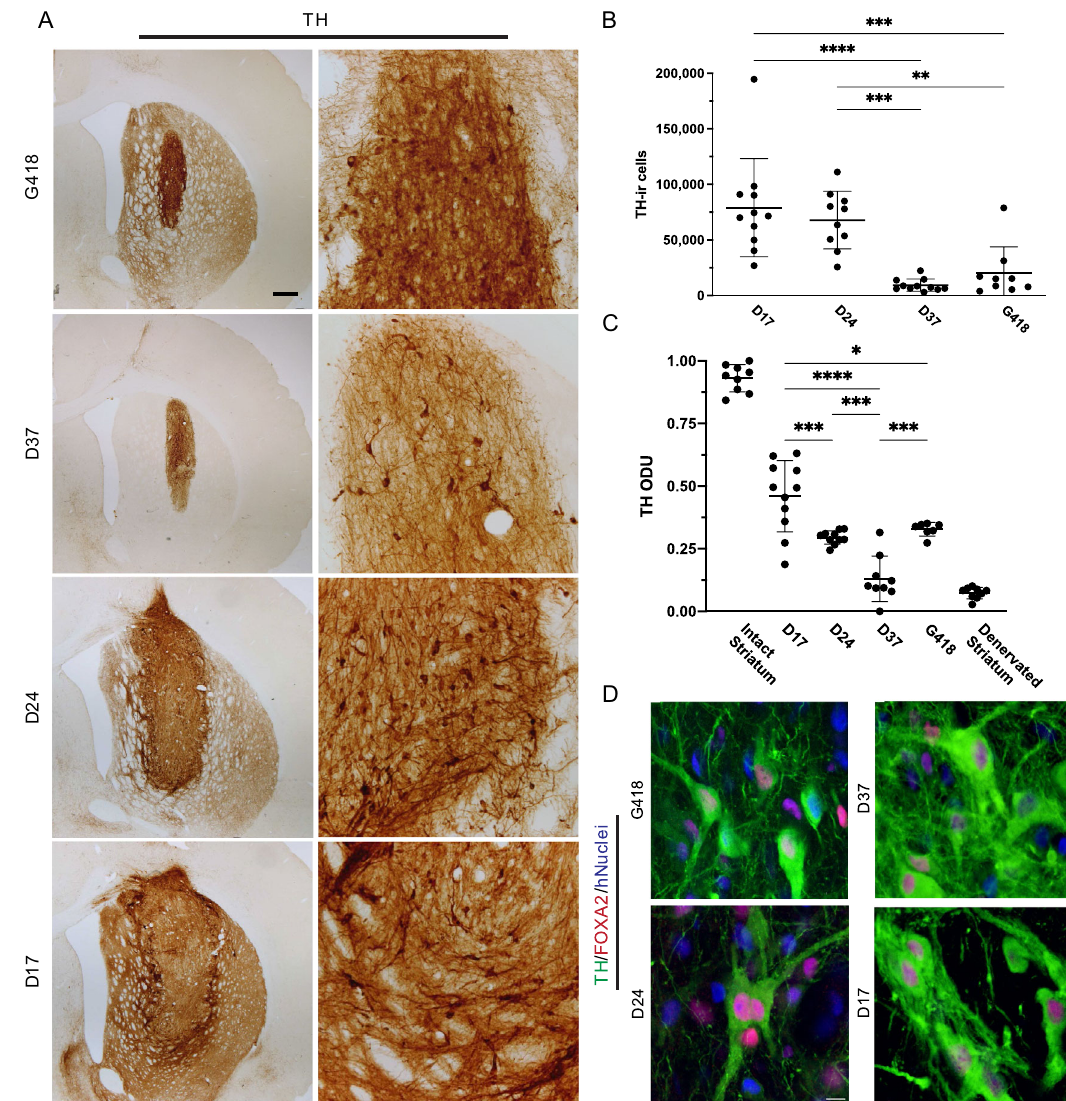
Fig. 4 Visualization of dopaminergic phenotype in vivo. Representative graft-containing sections stained for A DAB-processed TH. Quanti fi cation of B TH-ir cells contained within grafts after 6 months in vivo ( P < 0.0001 and P < 0.005 for D17 vs. D37/G418; P < 0.0005 and P < 0.01 for D24 vs. D37/G418, respectively). C Optical density of graft-derived TH-ir fi bers. Signi fi cant P values were calculated for D17 vs. D24, D37, and G418 ( P < 0.0005, P < 0.0001, P < 0.05); D24 vs. D37 ( P < 0.001); and G418 vs. D37 ( P < 0.0005). D Immuno fl uorescently triple-labeled for TH/FOXA2/hNuclei (green/red/blue). Scale bar A = 500 μ M; D = 20 μ M. * p < 0.05 ** p < 0.001 *** p <